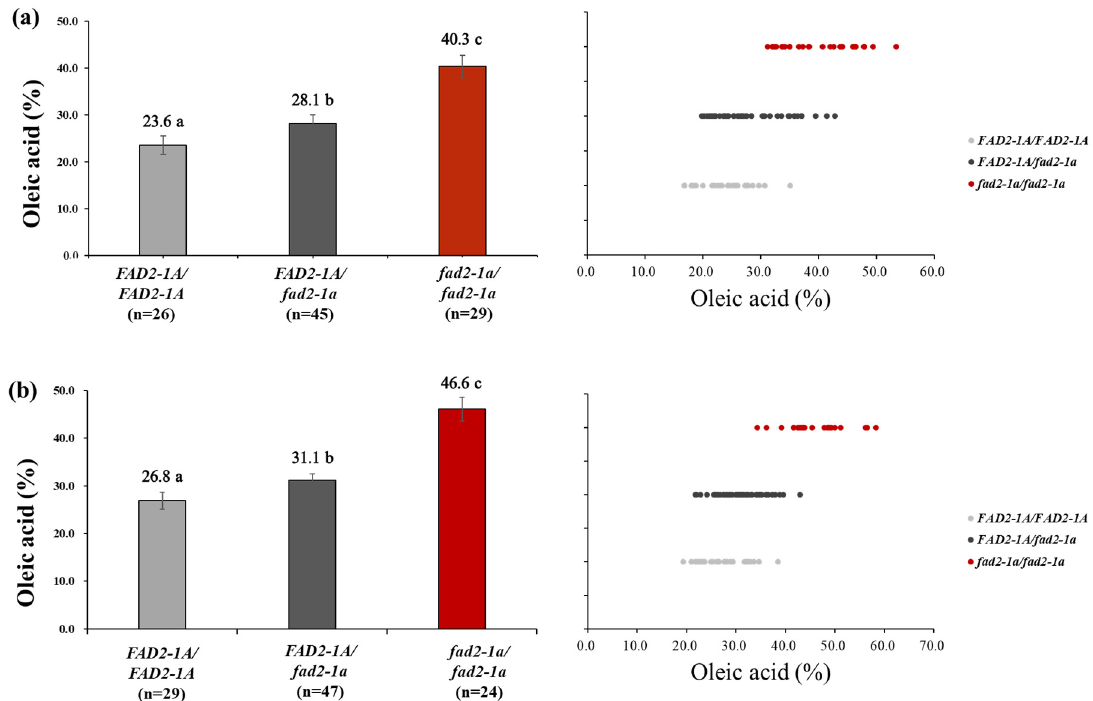
Figure 2. Distribution of oleic acid content from two segregating populations. ( a ) 100 F 2 seeds from a cross of PE529 and Pungsannamul showed altered oleic acid based on its genotype of FAD2-1A